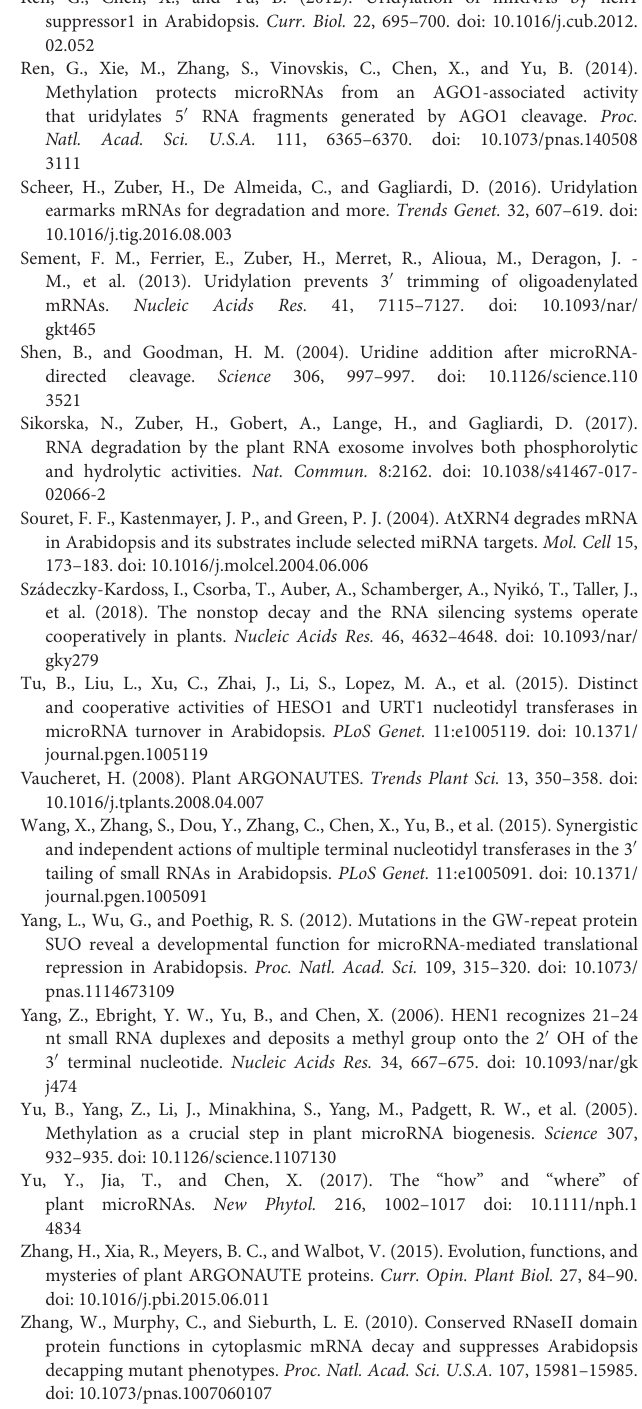
TABLE S3 | Exhaustive list of extensions found by 3 (cid:48) RACE-seq for MYB33 5 (cid:48) -cleavage fragments in WT for four biological replicates from dataset #1. TABLE S4 | Exhaustive list of extensions found by 3 (cid:48) RACE-seq for SPL13 5 (cid:48) -cleavage fragments in WT for four biological replicates from dataset #1.